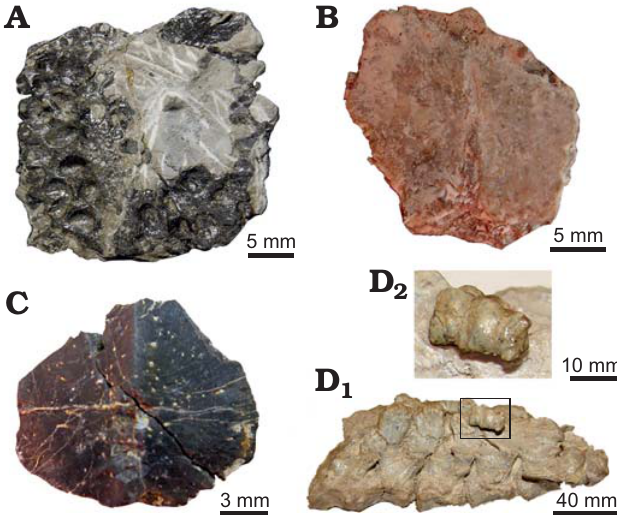
Fig. 1. Osteoderms examined in this study. A . Doswelliid Doswellia kalten- bachi Weems, 1980, USNM PAL 244214 from Near Doswell, Virginia, USA, Carnian. B , C . Doswelliid Vancleavea campi Long and Murry, 1995 from Coelophysis Quarry, “Siltstone Member” (GR 138) and Hayden Quarry, Petrified Forest Member (H4-102-08), Chinle Formation, New Mexico, USA, Early Norian. B . GR 138 (V1). C . H4-102-08 (V2). D . Pro- tero cham psid Chanaresuchus bonapartei Romer, 1971, PULR 07 from La Rioja province, Ladinian–Carnian; D 1 , general view of a single row of osteo- derms associated with presacral vertebrae; D 2 , detailed view of the sampled osteoderm (box inset in D 1 ). All elements in external view (except D, later- al-medial view), with the anterior margin facing the upper part of the figure.